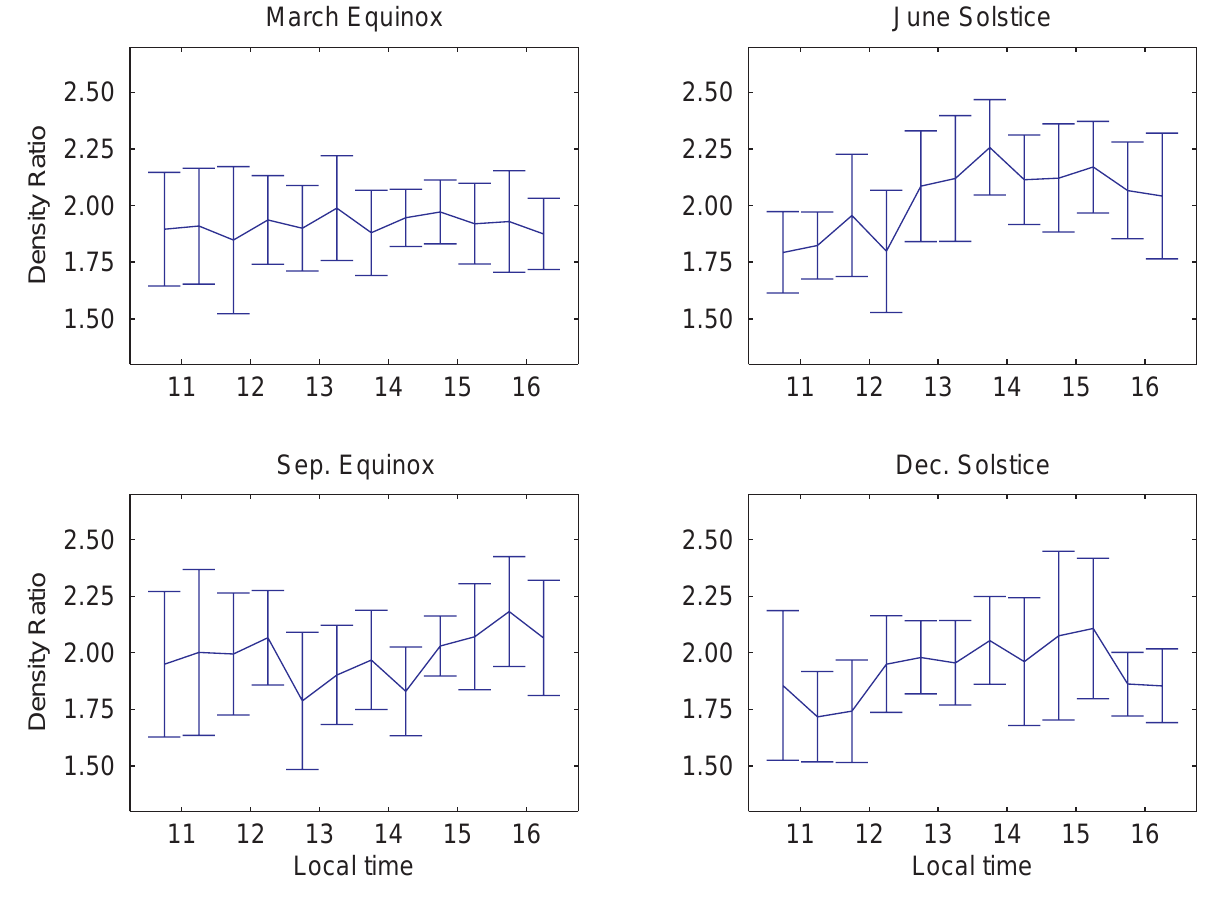
Fig. 6. Local time variation of the day-to-night density ratio separately for the four seasons. Only quiet days with A p < 15 have been considered. The error bars represent the standard deviation of the half-hours